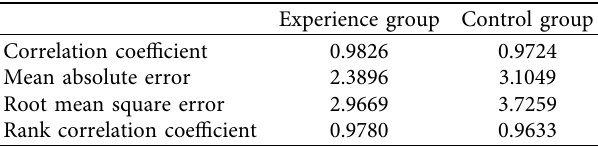
Figure 3: Correction effect. (a) White noise image. (b) Corrected Table 2: Comparison of edge correction performance of white noise distortion image.